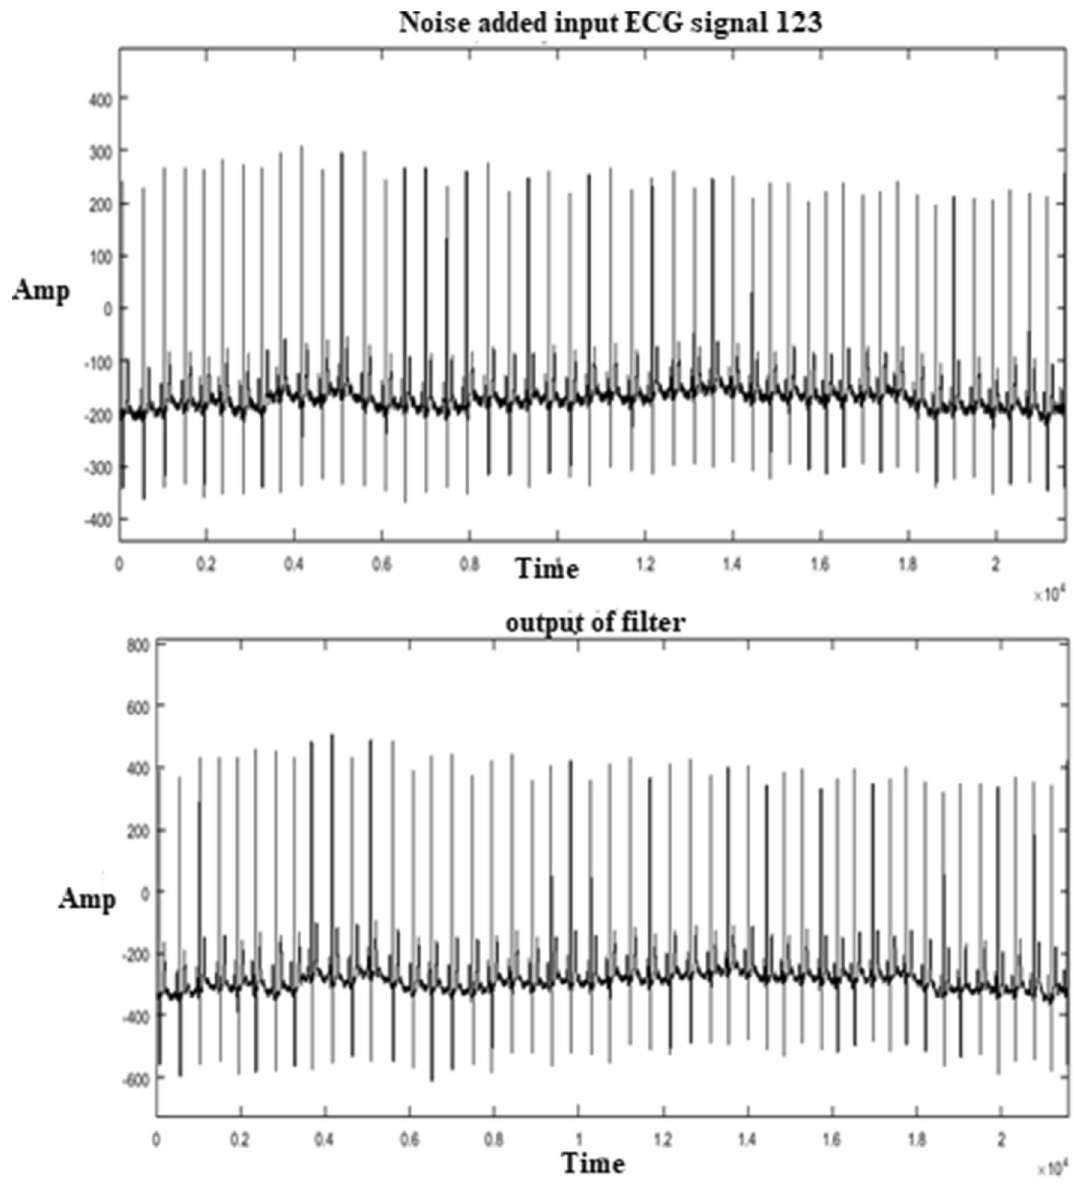
Figure 13. ECG detector output for a long term input